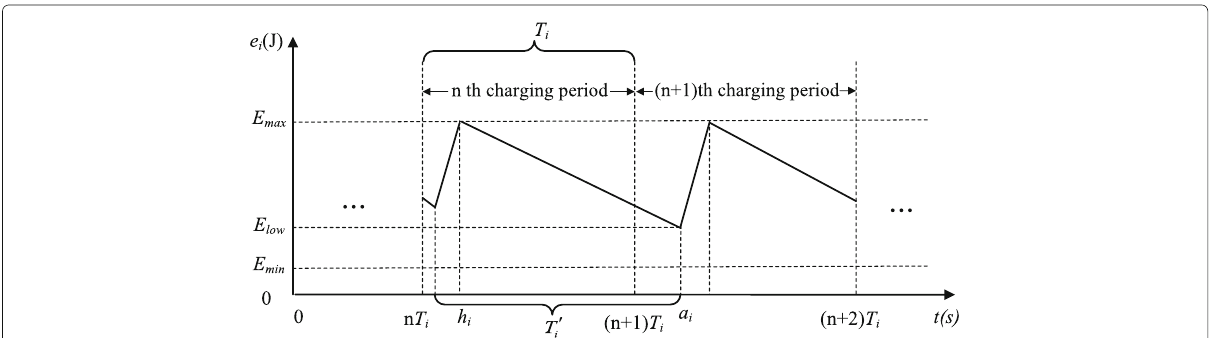
Fig. 3 Data routing for proposed ERSVC in the 50-node network. After implementing the first step of ERSVC, we can obtain the dating routing result. Multi-hop data routing is employed for forwarding data by the sensor nodes. In this figure, an arrow from node i to node j indicates that there is data transmitting from node i to node